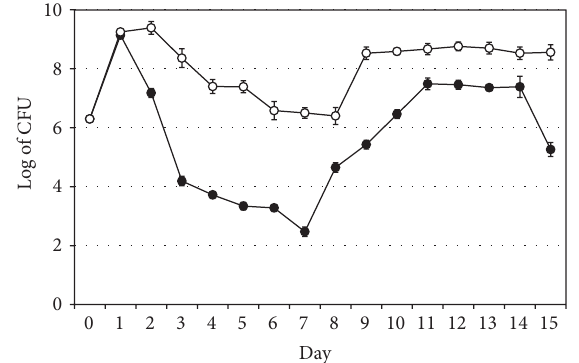
Figure3:Growthandsurvivalofwild-type V.cholerae (filledcircles) and the OmpA mutant strain (empty circles) when cocultivated with A. castellanii . Data represent mean ± SD from three different